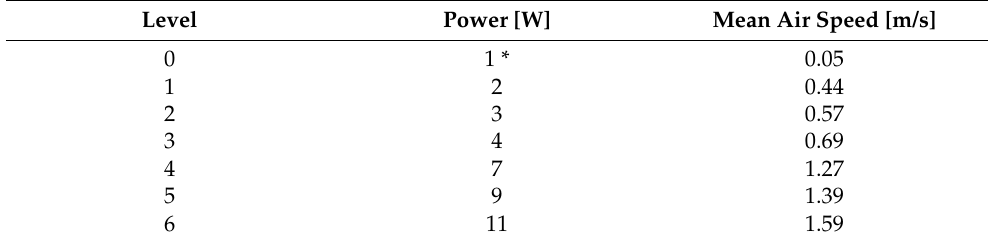
Table 1. Fan power and air speed at each setting.